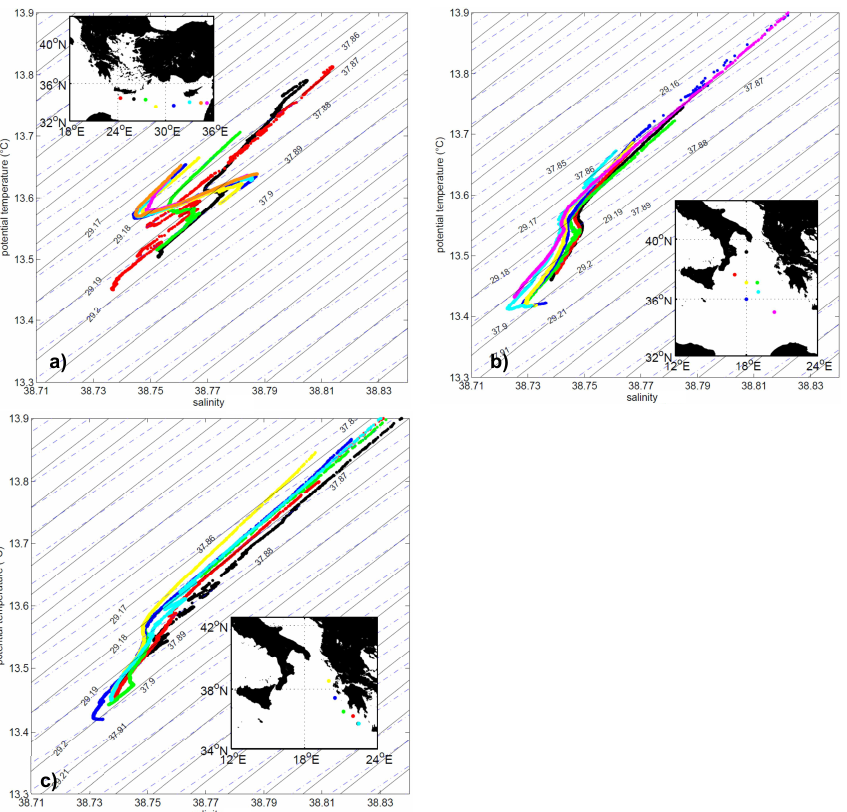
Figure 5. T – S diagrams of M84-3 and P414 CTD stations in (a) the Levantine basin along the eastern Hellenic Trench and south of the eastern Mediterranean ridge, (b) in the Ionian basin (for clarity only selected CTD stations are shown) and (c) in the western part of the Hellenic Trench. Values from 800m depth down to the bottom are taken into account. The inset panels show the location of the different